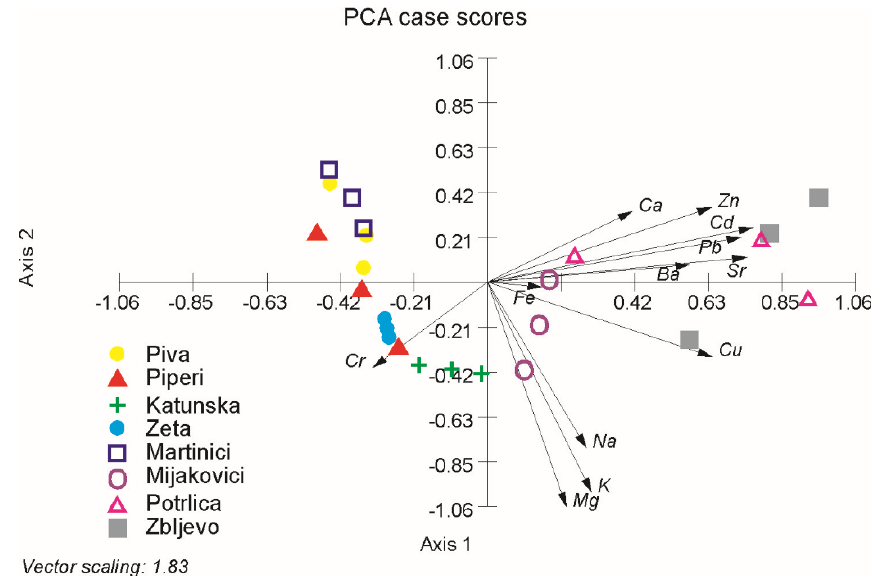
Figure 2. Principal component analysis (PCA) of the mineral content scores of analyzed Montenegrin honey samples.